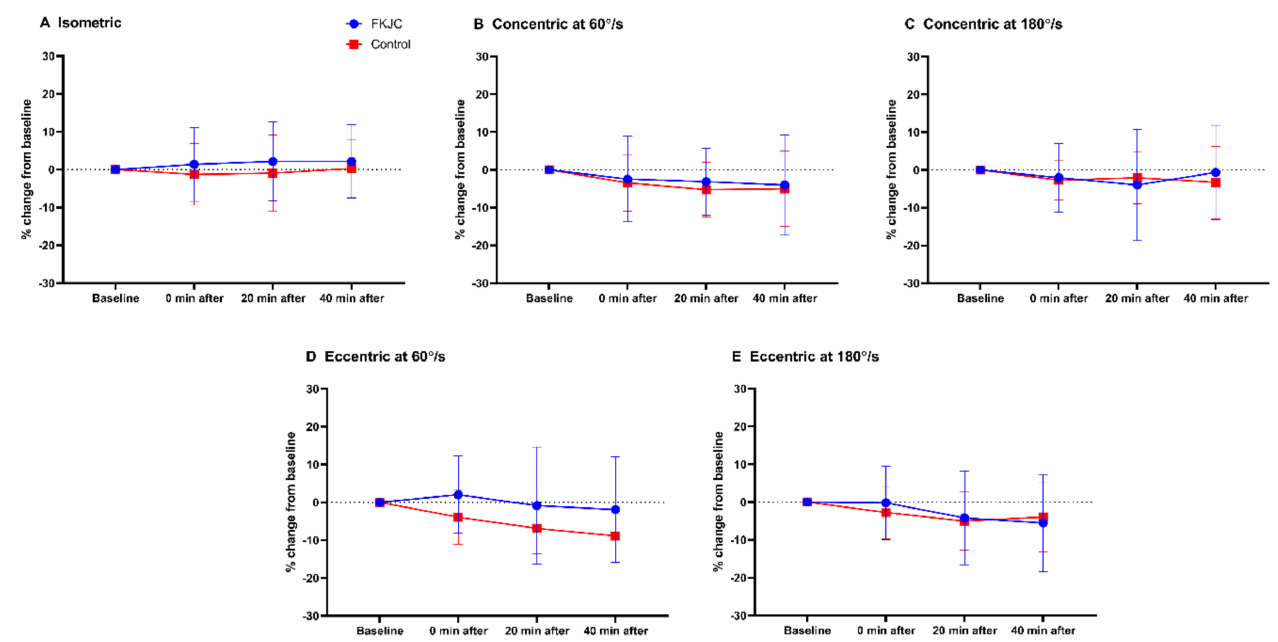
Figure 5. Percent change in peak torque from baseline during different modes of quadriceps contraction after FKJC (blue) and control (red) condition. FKJC, focal knee joint cooling. ( A ) Isometric, ( B ) Concentric at 60 ◦ /s, ( C ) Concentric at 180 ◦ /s, ( D ) Eccentric at 60 ◦ /s, ( E ) Eccentric at 180 ◦ /s. Data are presented as mean ± standard